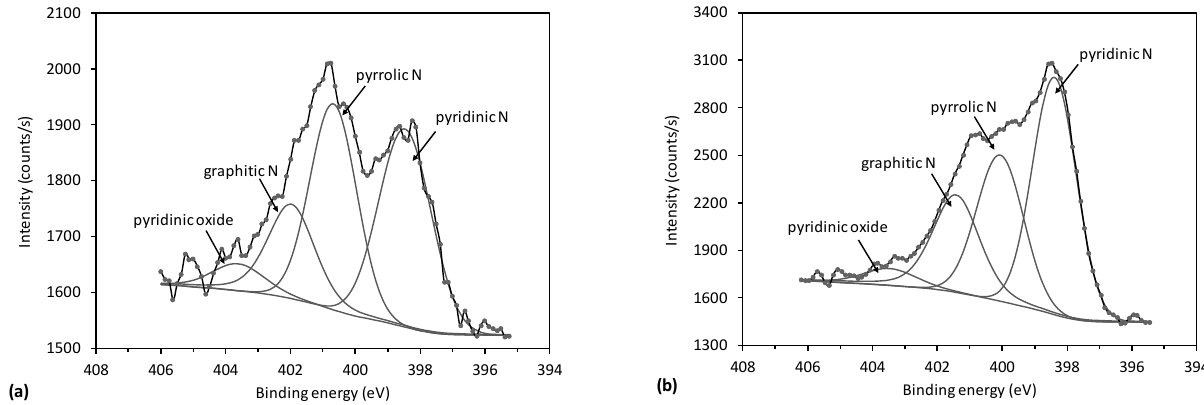
Figure 7. High-resolution nitrogen spectra N1s for N-doped carbon sample treated for ( a ) 60 s, and ( b ) 90 s.